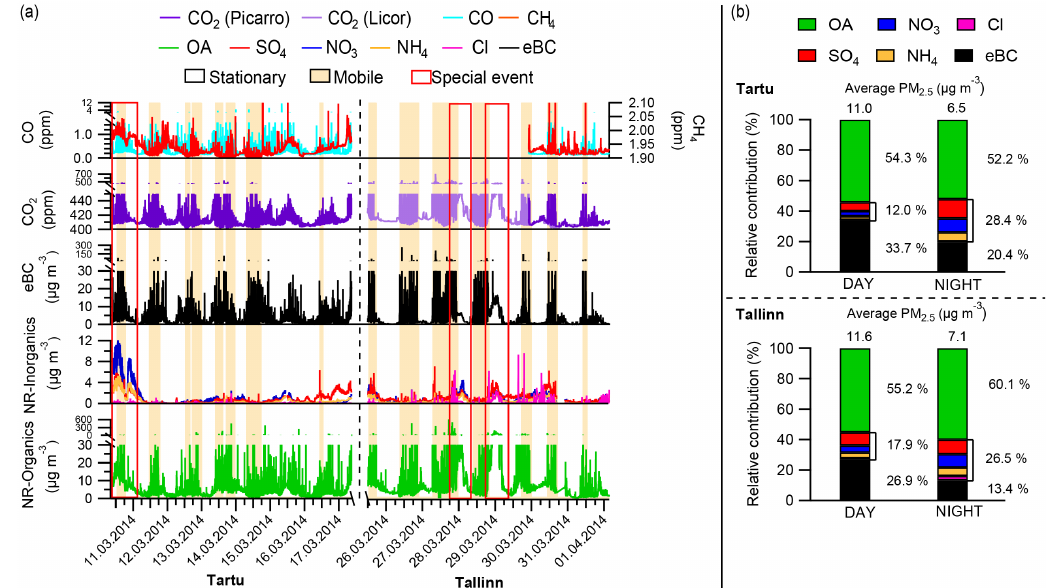
Figure 1. (a) Temporal evolution of all gas- and particle-phase measured components over the full measurement period; (b) average PM 2 . 5 (NR-PM 2 . 5 plus eBC) mass concentration and chemical composition for the measurements in Tartu (top panel) and Tallinn (bottom panel), with day- and nighttime distinction. Note: special events were